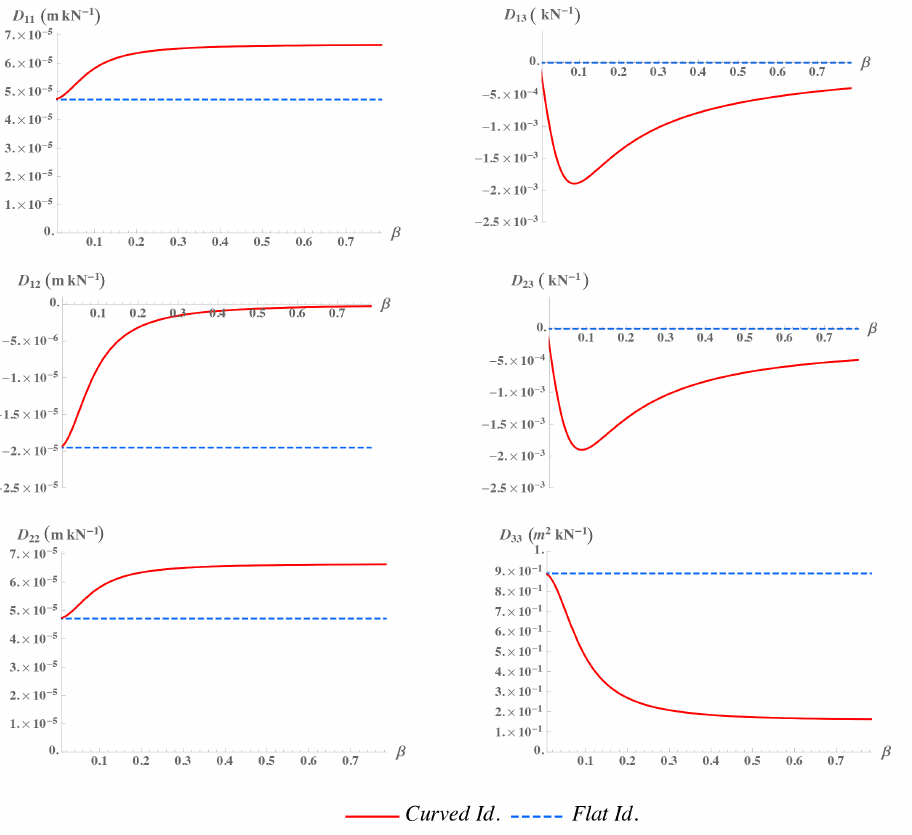
Figure 11. The six curves of D 11 ( β ) , D 12 ( β ) , D 22 ( β ) , D 13 ( β ) , D 23 ( β ) , D 33 ( β ) , (red, solid line), su- perimposed with the corresponding D 11 , D 12 , D 22 , D 13 , D 23 , D 33 , (blue, dashed line), in the case of l = 1.0 m, E = 1.0 × 10 4 MPa, A b = 1.5 × 10 − 3 m 2 , Ad = 1.5 × 10 − 3 m 2 , Jb = 1.35 × 10 − 6 m 4 .